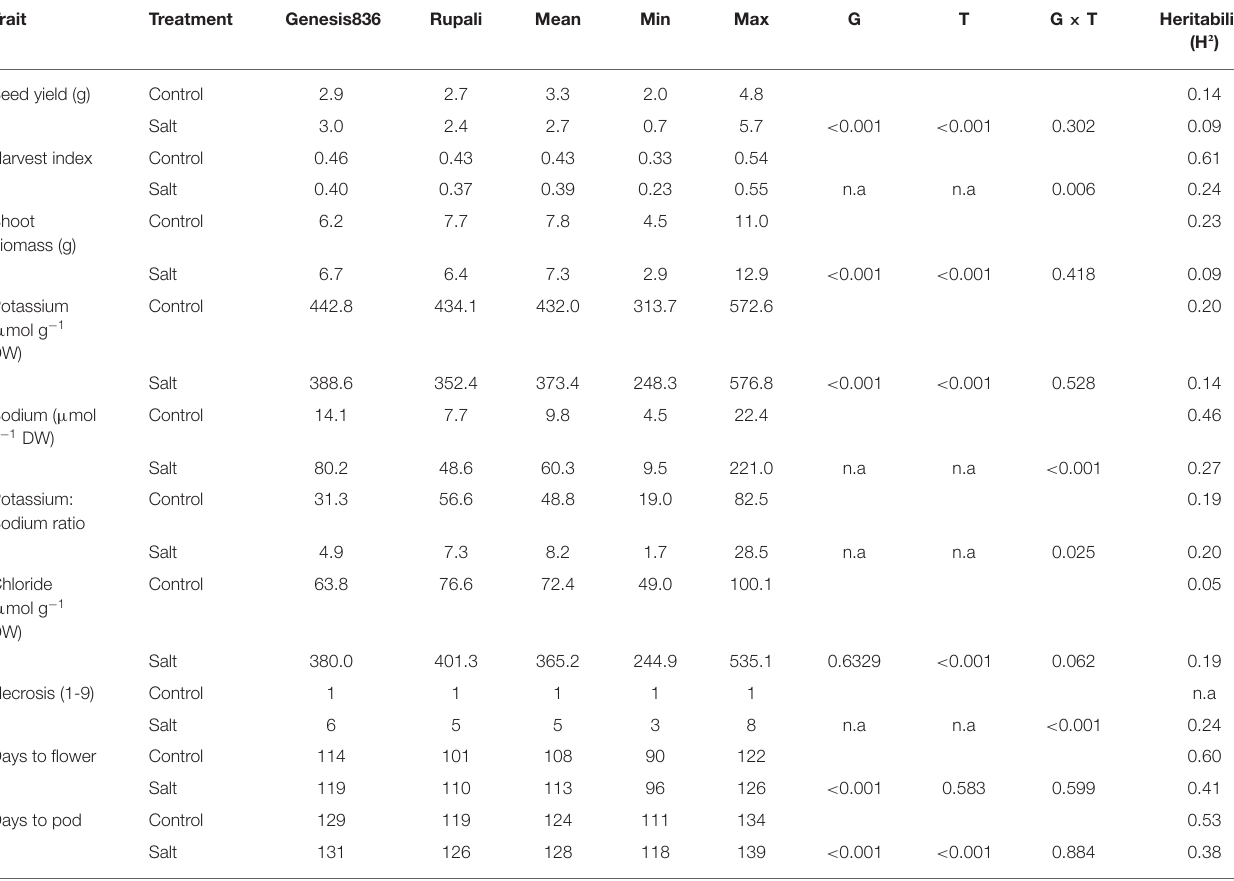
Overall trait means, minimum and maximum values, and p-values for effects of genotype (G), treatment (T), and genotype by treatment interaction (G × T) are given for Genesis836, Rupali, and the RIL population consisting of 181 genotypes. n.a is indicated for non-informative p-values where G × T is significant. Estimates of heritability (H ² ) for different traits